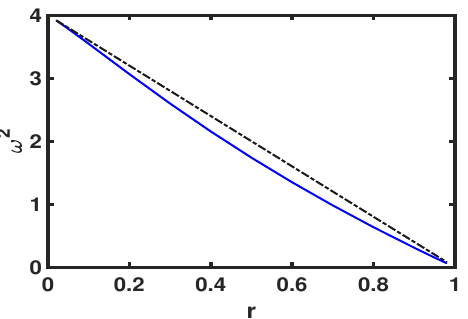
Figure 4 . Small kink: squared frequencies ω 2 of vibrational states as a function of the parameter r (blue line). The black dashed line corresponds to the threshold of the continuum